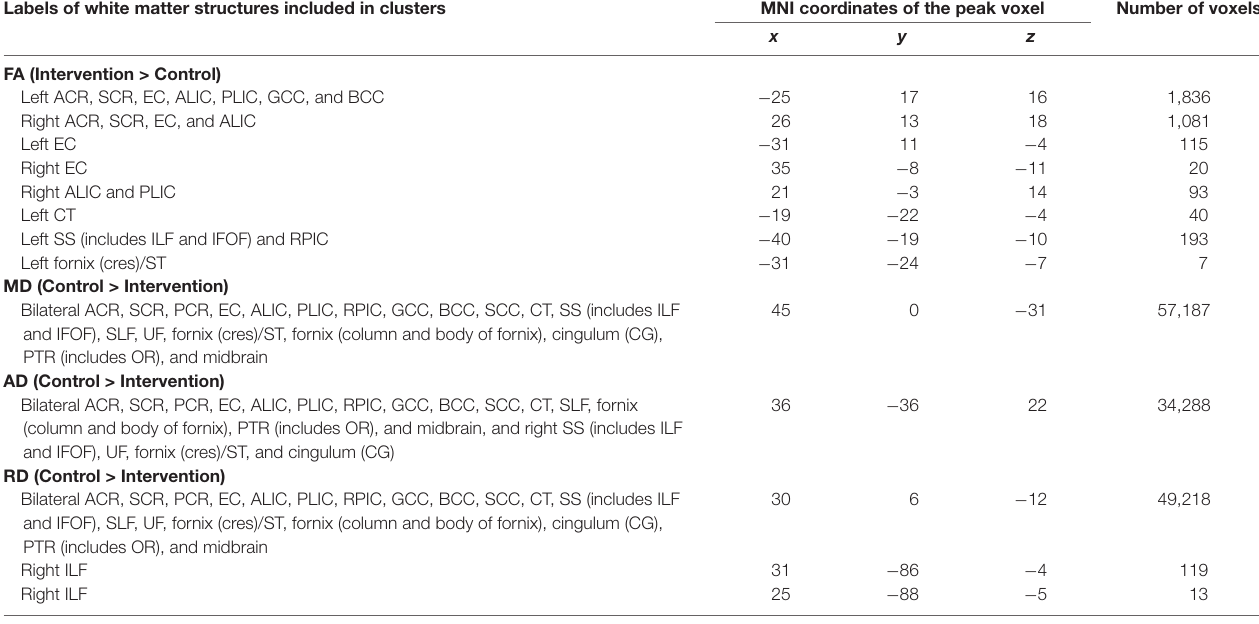
TABLE 1 | White matter structures showing significant differences in DTI metrics between the intervention and control groups. Labels of white matter structures included in clusters MNI coordinates of the peak voxel Number of voxels